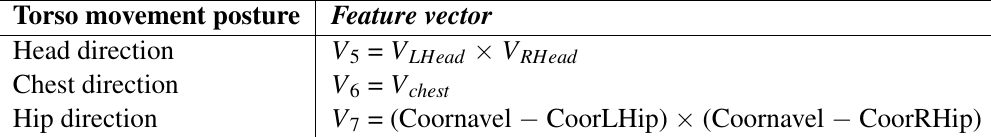
Table 2 Torso pose feature vectors.